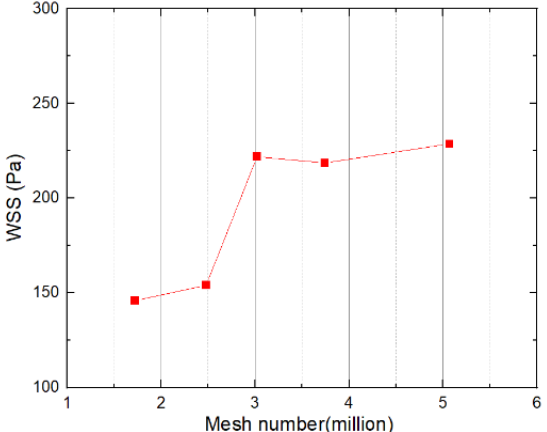
Figure 9. Grid independency study (WSS vs. mesh number).